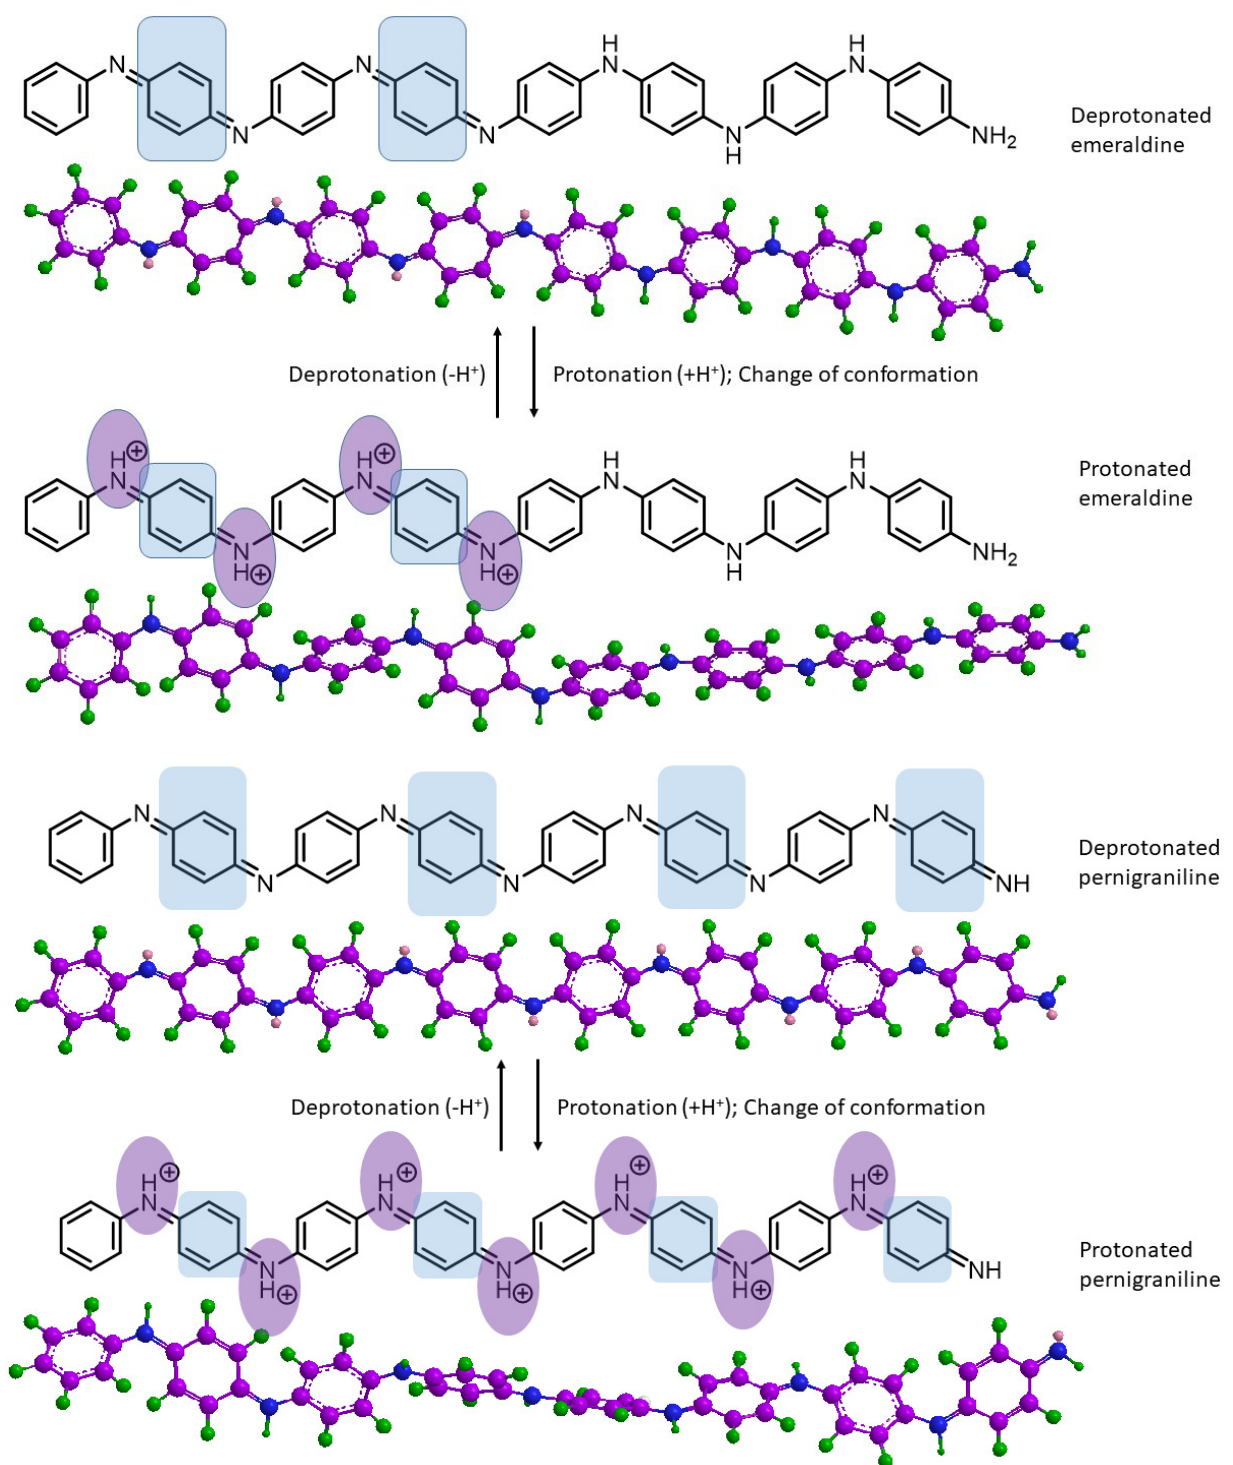
Figure 10. Different oxidation states of polyaniline and effects of oxidation on the conformation of the molecule. The protonated species of the polyaniline molecule are conducting, whereas the deprotonated species are non-conducting.